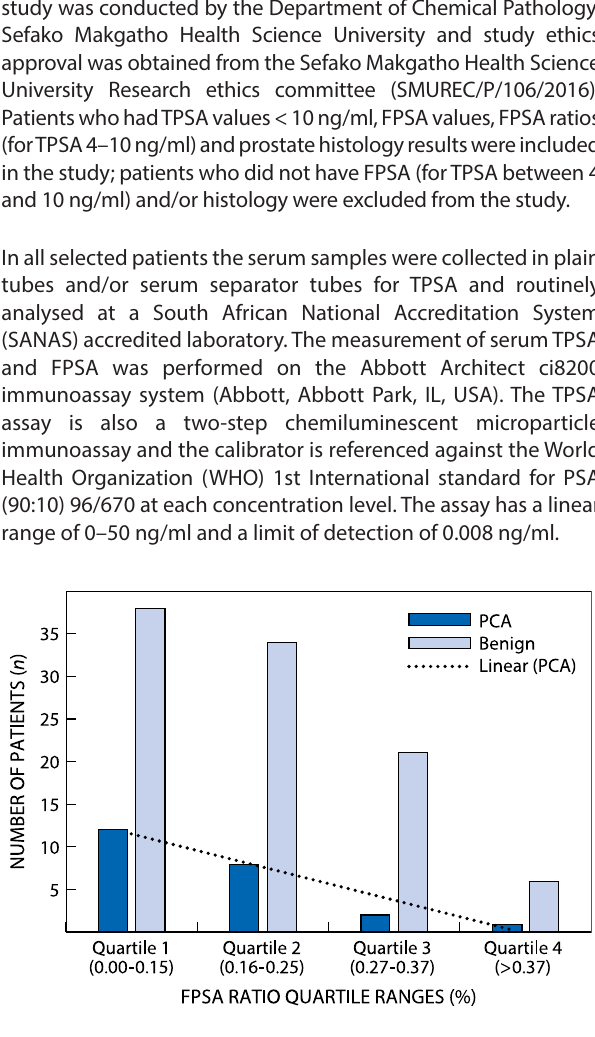
Figure 1: Quartiles of %FPSA